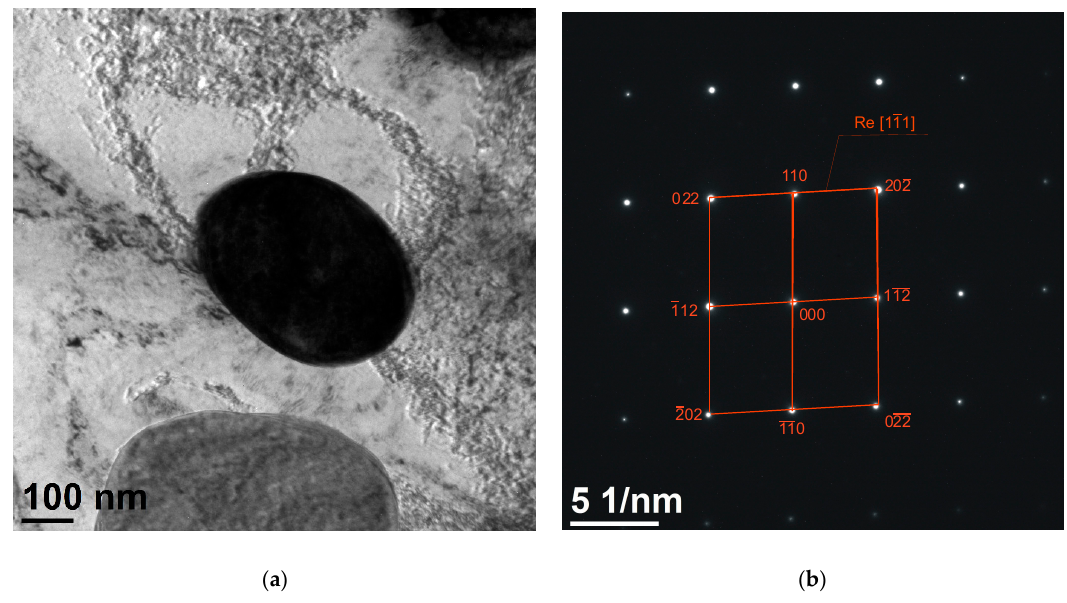
Figure 12. Structure of Cu–2Ni–1Si alloy modified with Re: dark field image ( a ), di ff raction pattern of